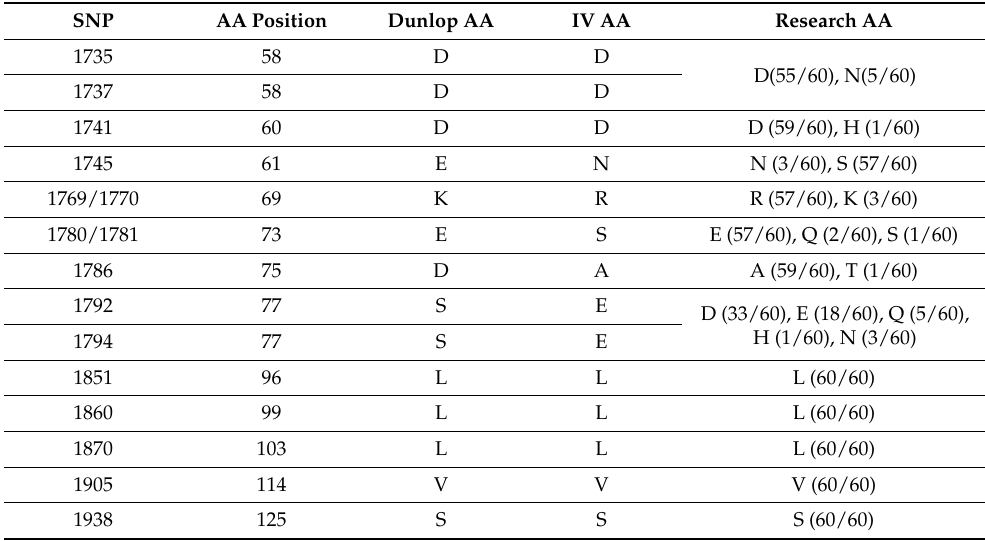
Table 10. Amino acid substitution between strain IV, Dunlop, and the study